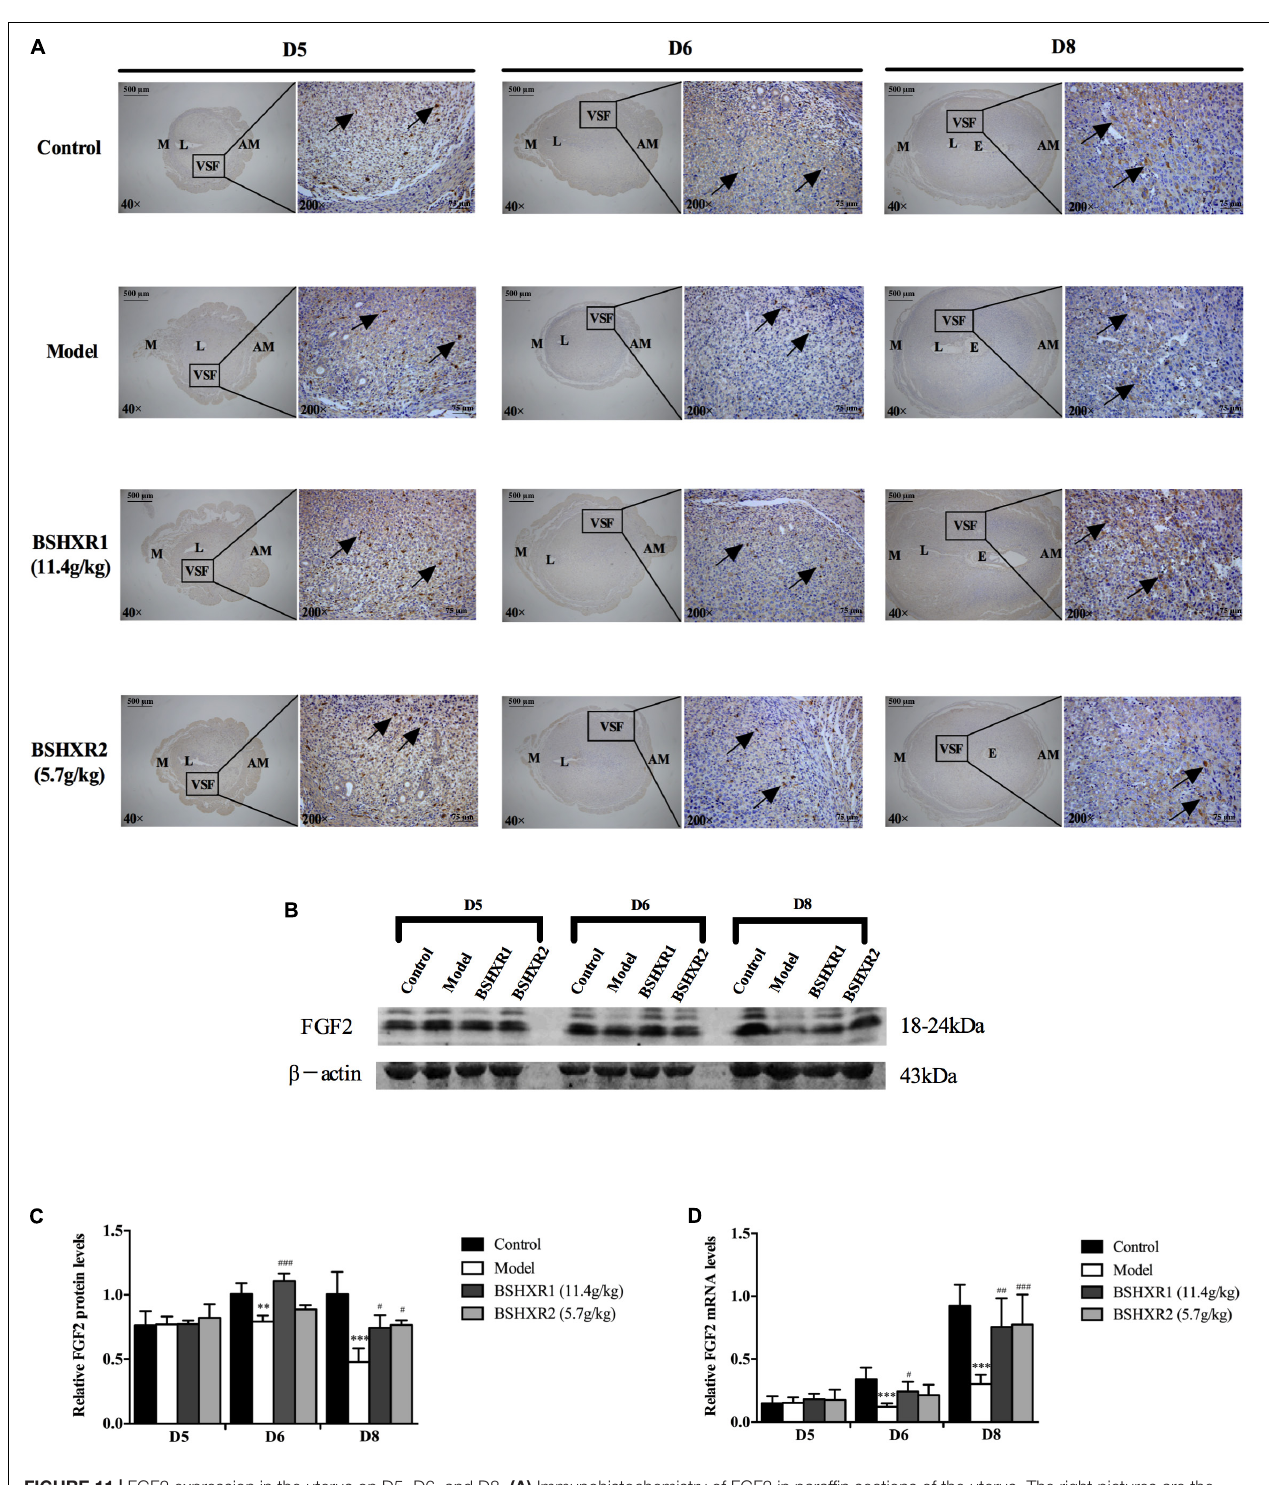
FIGURE 11 | FGF2 expression in the uterus on D5, D6, and D8. (A) Immunohistochemistry of FGF2 in paraffin sections of the uterus. The right pictures are the higher magnification images of the black boxes on the left. Arrow indicates the positive staining. L, lumen; E, embryo; M, mesometrial; AM, anti-mesometrial; VSF, vascular sinus folding. Original magnification and scale bar were shown in the pictures. (B) Protein levels of FGF2 in pregnant uterus (remove embryo) by western blot analysis ( n = 3). (C) Quantification of FGF2 protein expression. (D) mRNA levels of FGF2 in pregnant uterus (remove embryo) by qRT-PCR ( n = 5). Data represent mean ± SD. β -actin was used as the reference. ∗∗ P < 0.01 and ∗∗∗ P < 0.001 when compared to control group. # P < 0.05, ## P < 0.01, and ### P < 0.001 when compared to model group.